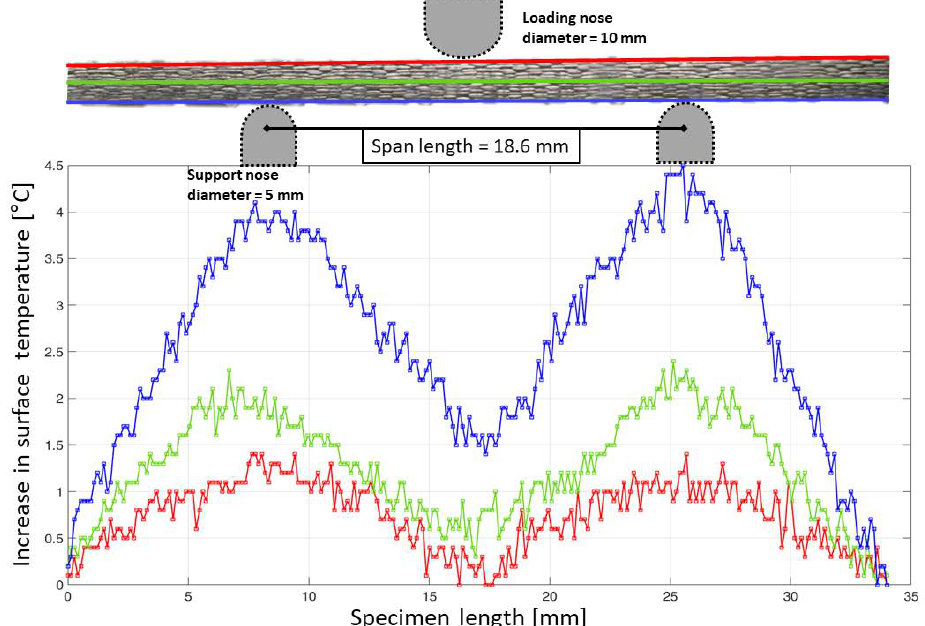
Figure 7. Characteristic temperature profile across the length of the undamaged specimen in the top, middle, and bottom regions of the specimen surface when tested at a cyclic amplitude of 40 µ m and pause time of 4